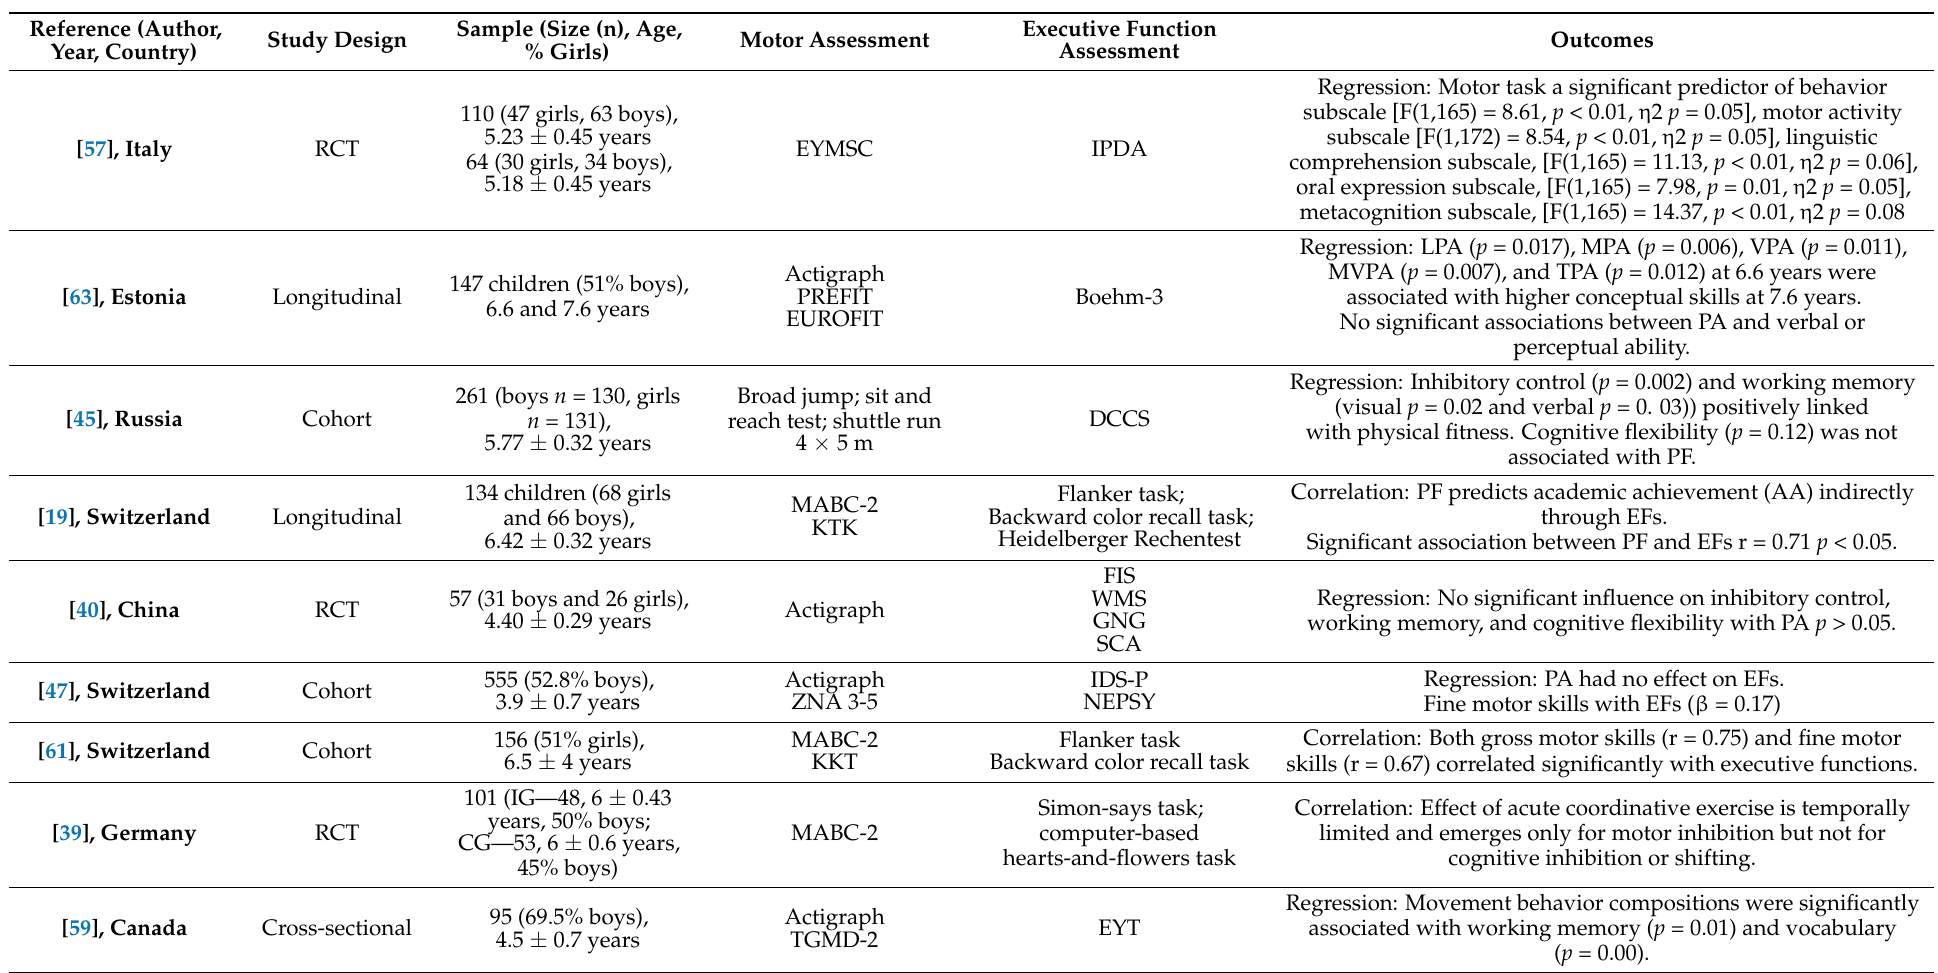
Table 1. General characteristics of the studies included in the systematic